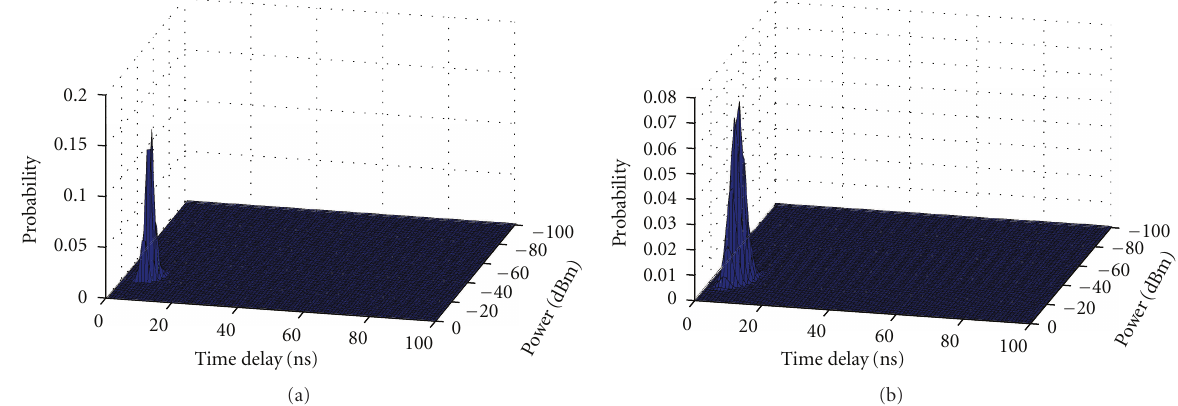
Figure 12: Joint distribution of τ and α (a) measured and (b) estimated by model.